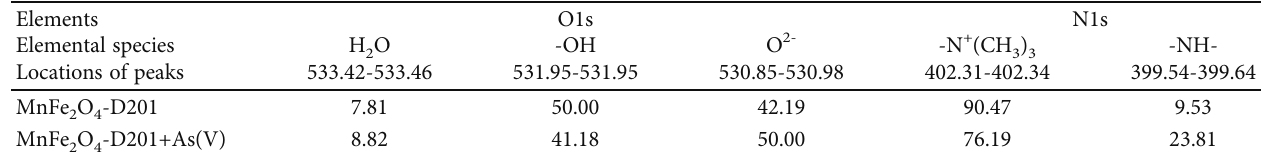
Table 4: Normalized peak areas of XPS spectra in Figure